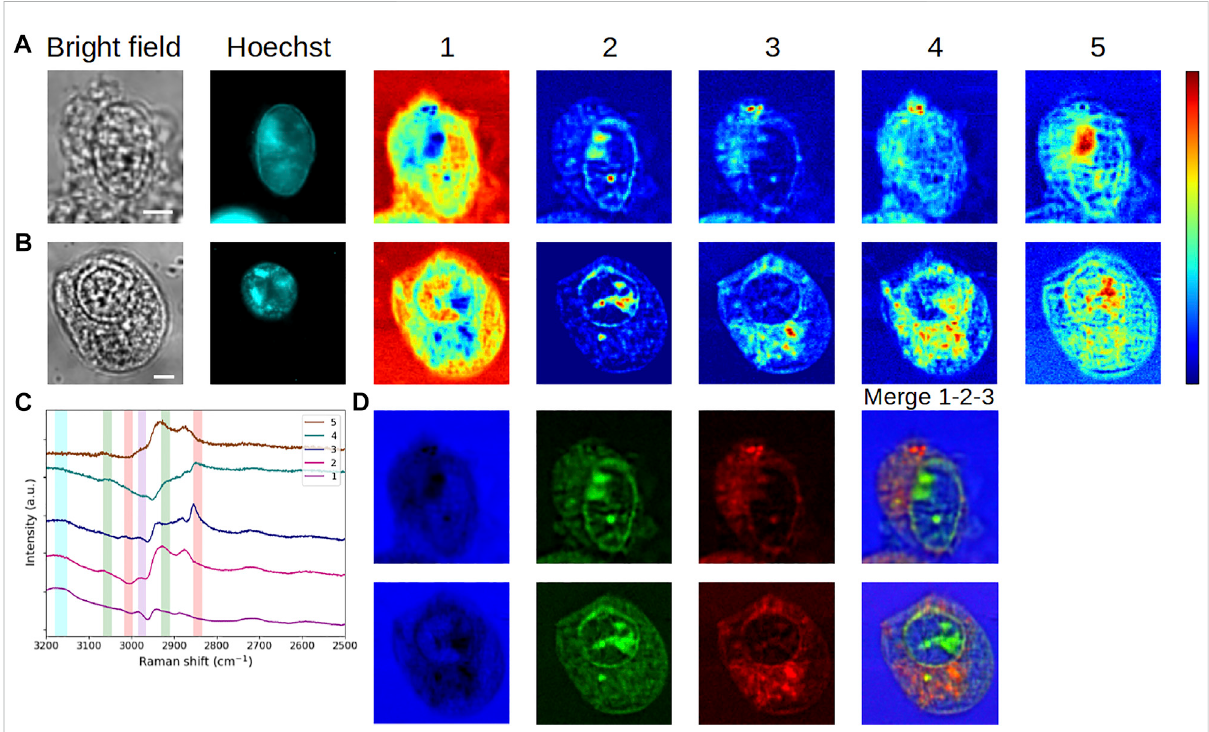
FIGURE 7 Analysis of living cells overexpressing TrkB cancer-related protein, in the presence or absence of its ligand BDNF. Application of the MC 2 approach to the analysis of a cell that was incubated without BDNF, with its (A) concentration maps and (C) corresponding spectra, considered as referencespectra.Verticalbarshighlightthepresenceoflipids(red),proteins(green),DNA/RNA(violet),andwater(blue). (B) Concentrationmapsofa cell that was incubated with BDNF, obtained by the projection of its dataset onto the reference spectra. (D) False-color images corresponding toconcentrationmaps#1(blue),#2(green),and#3(red).Bothcellswereincubatedwithout/withBDNFduring72 handstainedwithHoechst33342. The scale bar corresponds to 5 μ